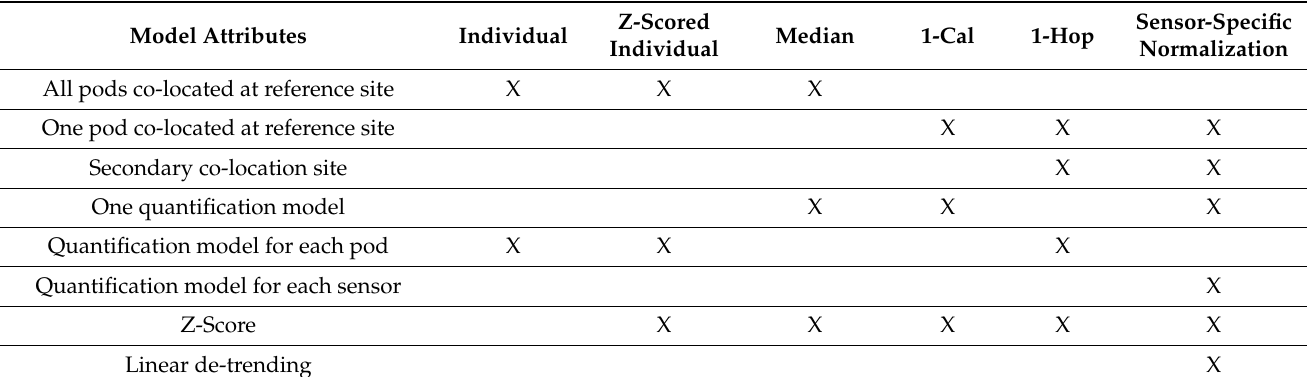
Table 3. Calibration Model Attributes, where X denotes a model having the selected attribute. Model Attributes Individual